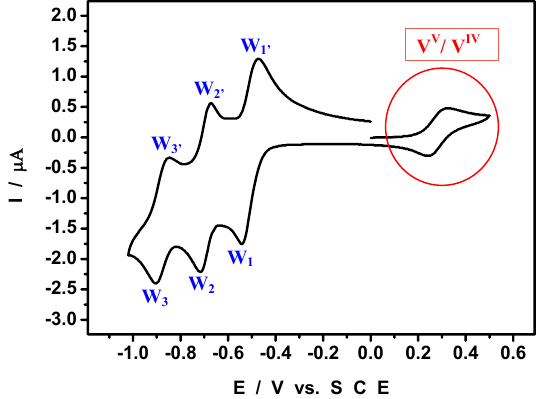
Figure 2. Cyclic voltammogram (CV) of 2 × 10 -4 M HPV IV in a pH = 5 medium. The